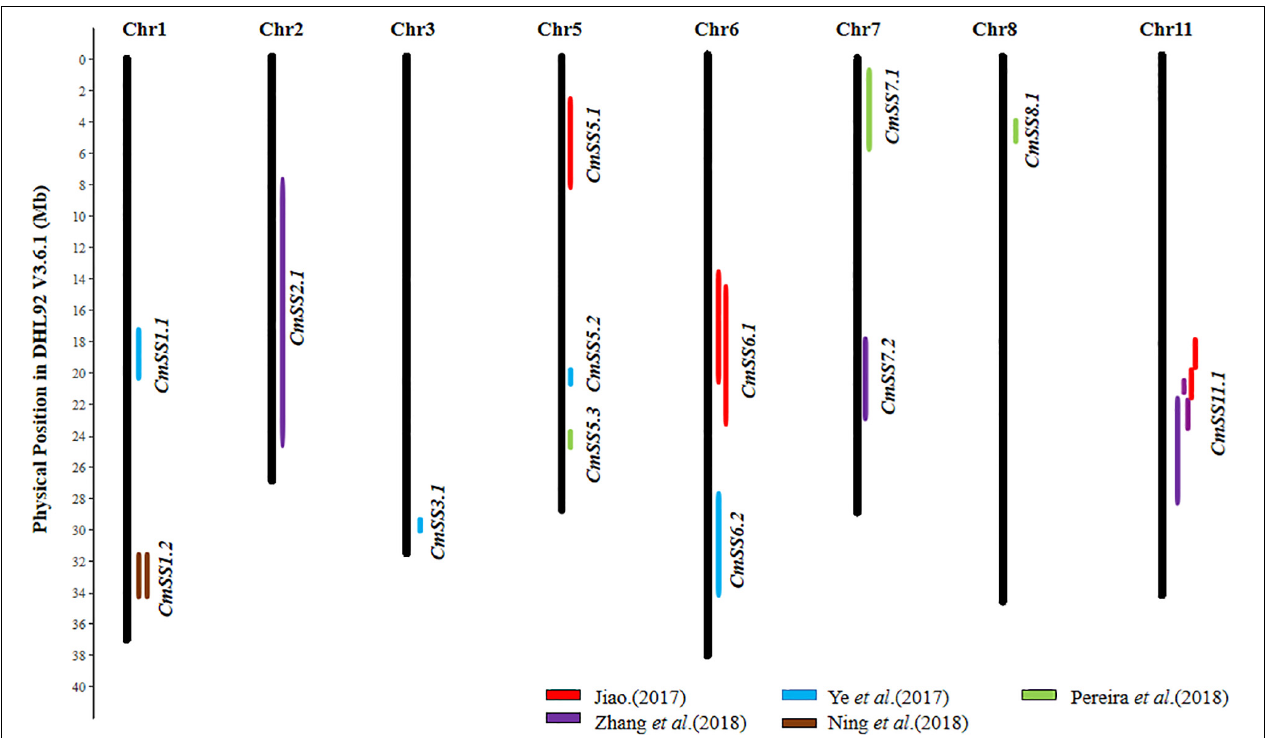
FIGURE 4 | Distribution of 13 seed size (SS) consensus QTL in the melon (DHL92 V3.6.1) draft genome. Physical LOD intervals of QTL identified from different studies are presented to the right of each chromosome. QTL detected by the same study are showed with same color. Only chromosomes harboring seed size QTL are